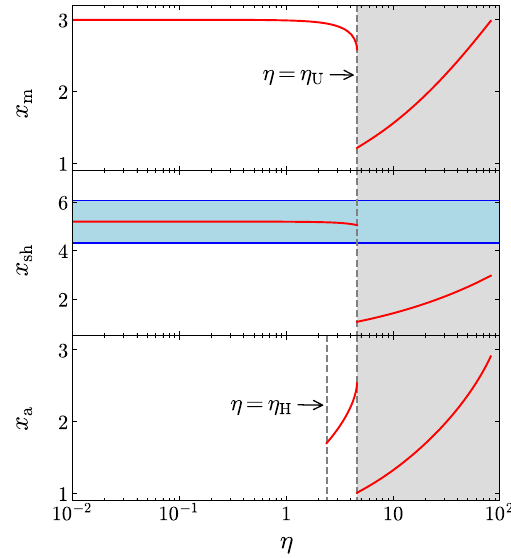
Fig. 2 The (dimensionless) radii of the photon sphere x m (top), the gravitationally lensed photon sphere x sh (middle) and the antiphoton sphere x a (bottom) with respect to η . The blue shadowed region of x sh is consistent with the EHT observation [78], while the grey shadowed domain of η is ruled